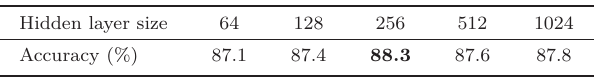
Table 1 Effect of hidden layer size on accuracy using